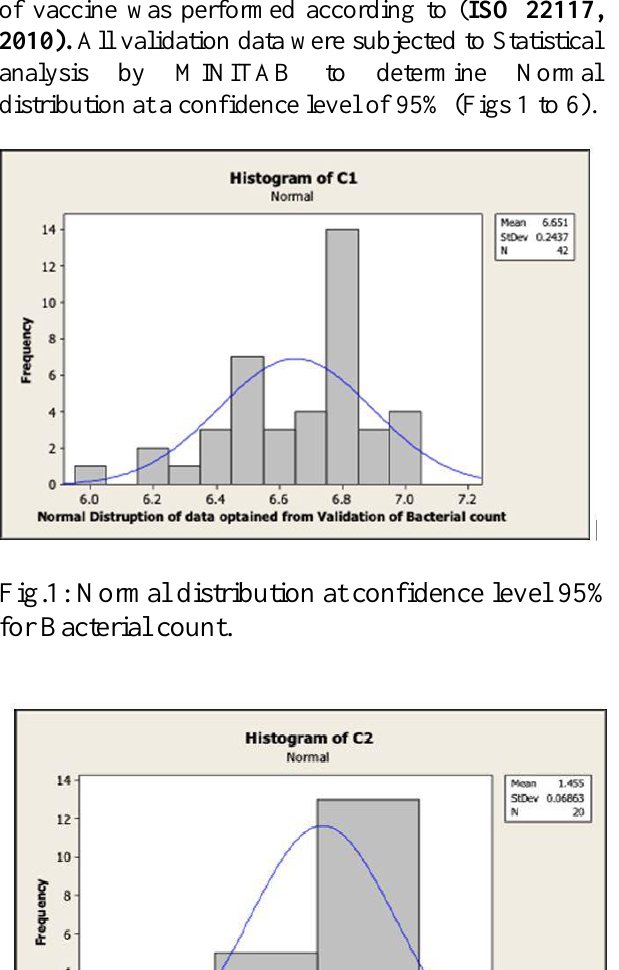
Fig.5: Normal distribution at confidence level 95% for Anti-body titer) by using Virus Neutralization Test (VNT).